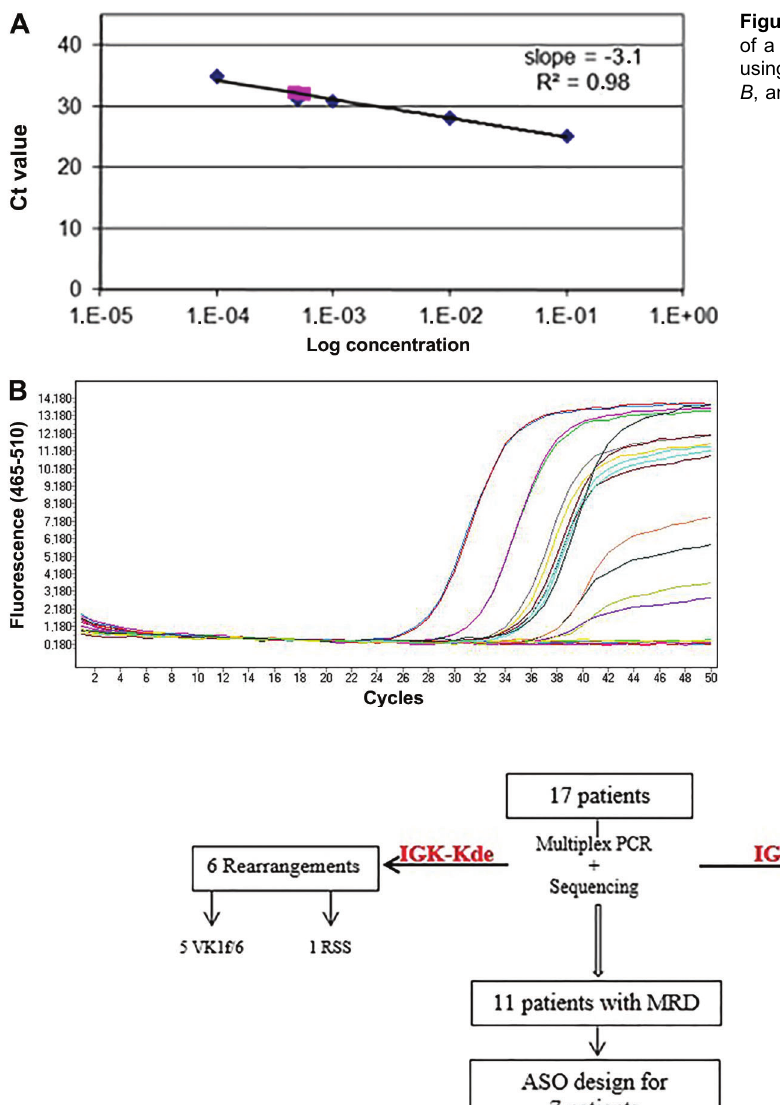
Figure 2. Minimal residual disease monitoring of a B lineage acute lymphoblastic leukemia (P1)